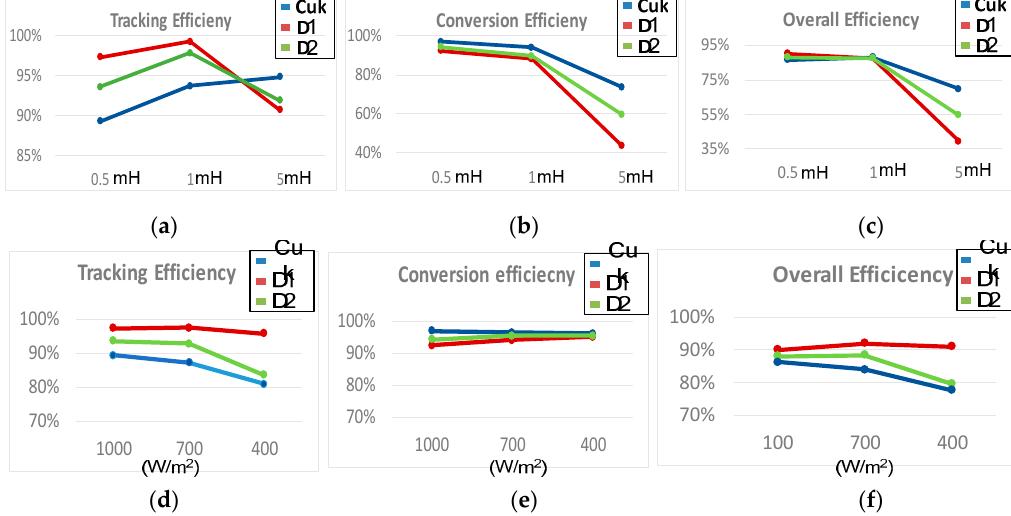
Figure 7. Tracking, conversion and overall efficiencies of the three investigated converters for: ( a – c ) different inductance values at 1000 W/m 2 ; ( d – f ) variable irradiance levels at 0.5 mH.